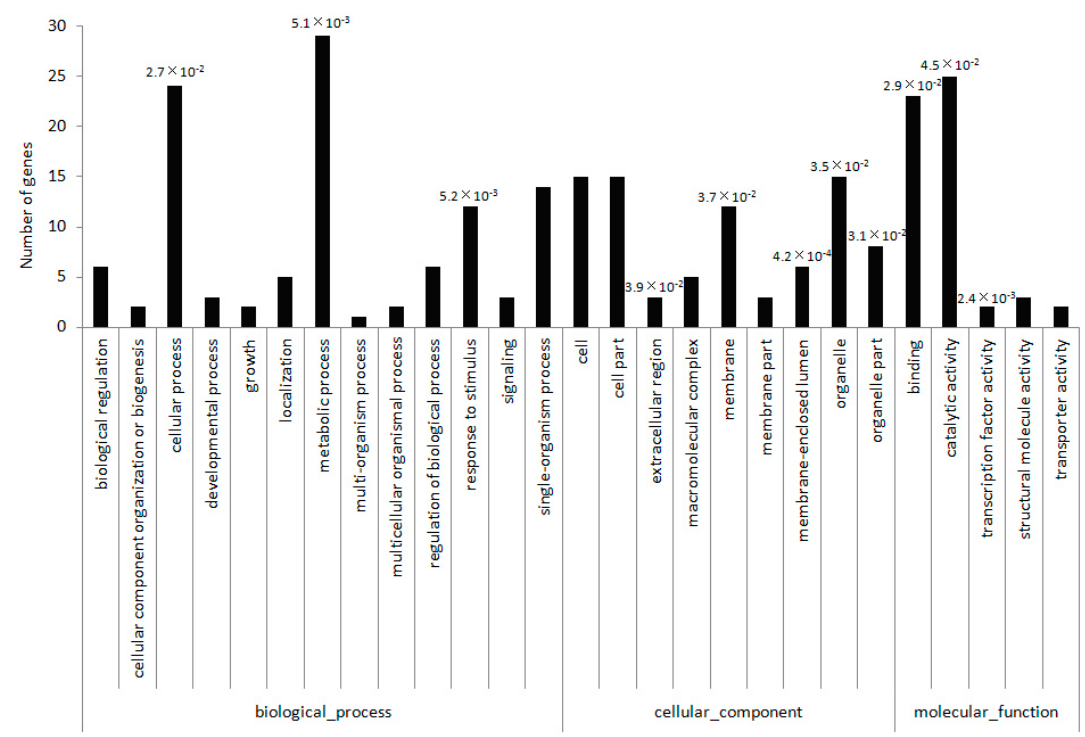
Figure 1. Gene ontology classification of blueberry miRNA target genes. Number above the bar indicatesthe p -value of target genes enriched in functional category. Only the enrichments with p -values less than 0.05 were showed.